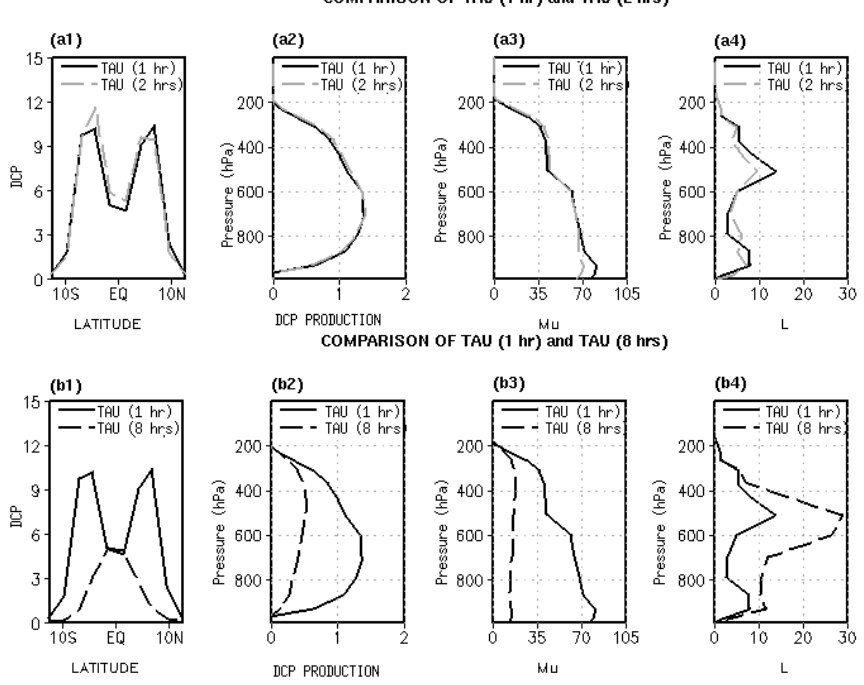
Fig. 3. Top panel shows the comparison of TAU (1h) and TAU (2h), and bottom panel shows the comparison of TAU (1h) and TAU (8h). (a1) and (b1) show the zonal averaged time mean surface reaching DCP (mm/day), (a2) and (b2) show the vertical profile of area (0 ◦ E to 360 ◦ E and 12.5 ◦ S to 12.5 ◦ N) averaged DCP production (kg/kg/day), (a3) and (b3) show the vertical profile of area (0 ◦ E to 360 ◦ E and 12.5 ◦ S to 12.5 ◦ N) averaged updraft mass flux (mb/day), and (a4) and (b4) show the vertical profile of area (0 ◦ E to 360 ◦ E and 12.5 ◦ S to 12.5 ◦ N) averaged cloud water (gram/m 2